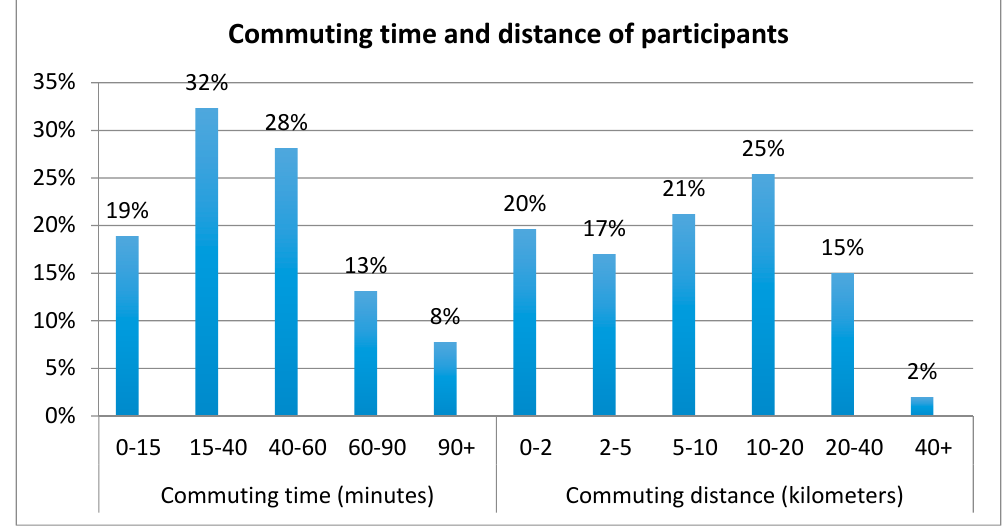
Figure 1. Commuting time and distance of participants.